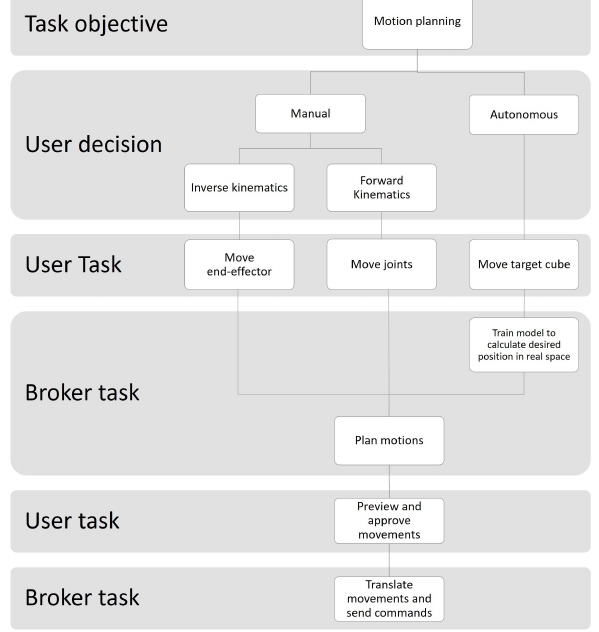
Figure 3. A flowchart of the DT-HRI use case scenario.